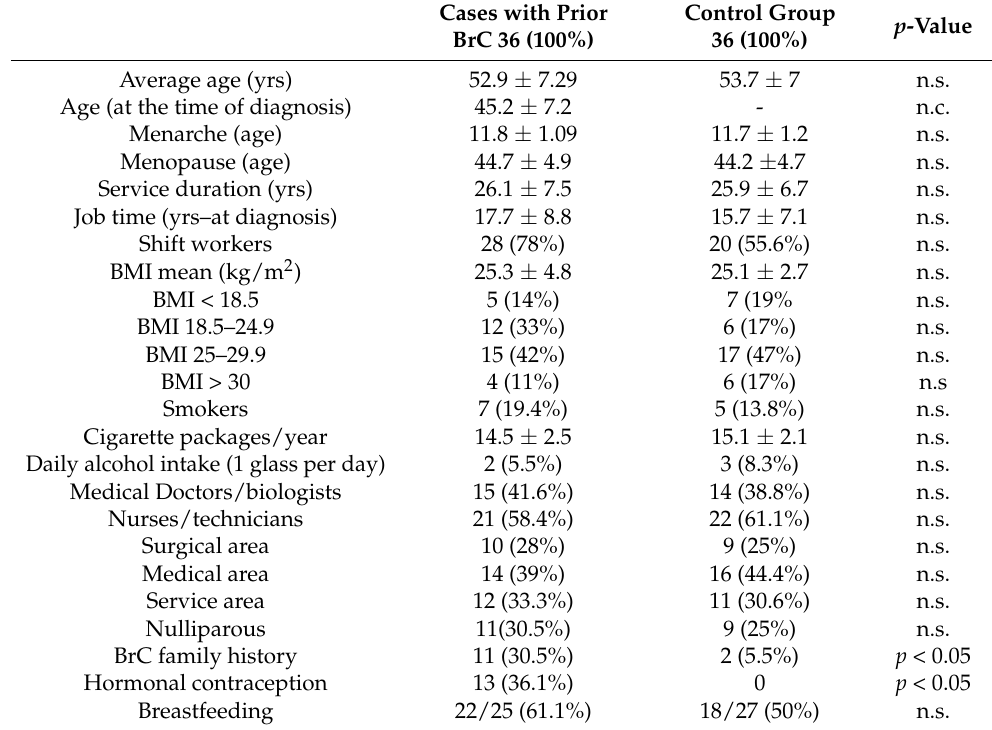
Table 1. Sample main characteristics.